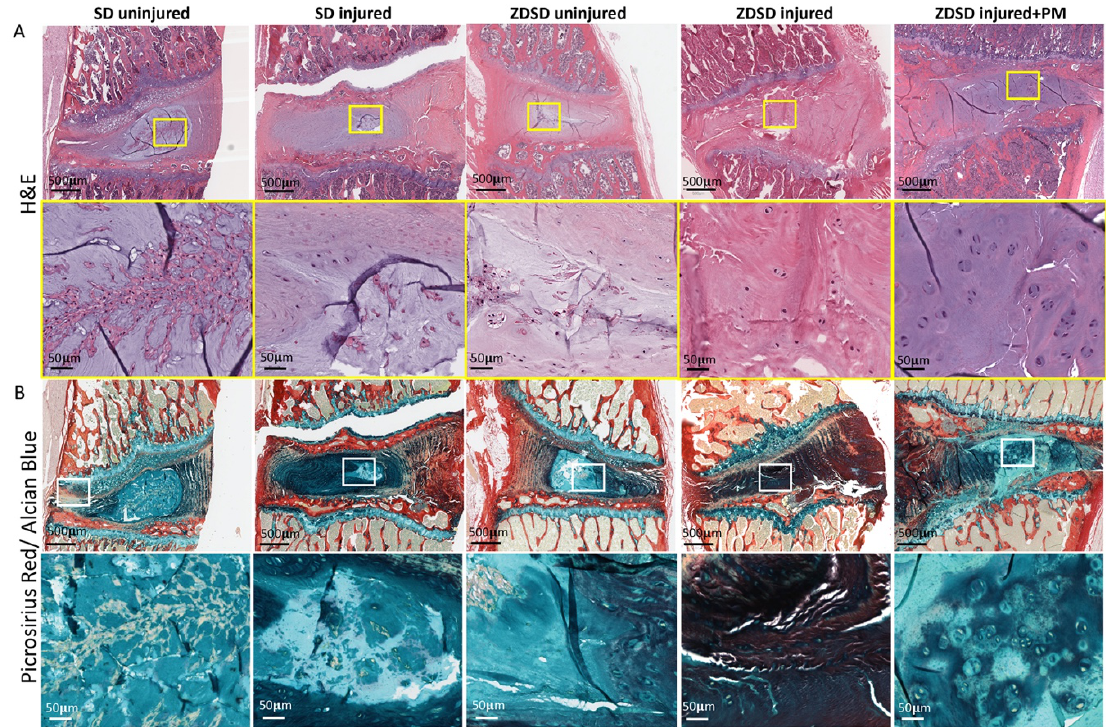
Figure 3. IVD lesion and NP destruction in response to needle injury is attenuated in rats receiving PM. ( A ) H&E-stained and ( B ) Picrosirius red/Alcian blue—stained lumbar discs from IVDs from various experimental groups harvested at 8 weeks post-surgery. Upper images in panels A and B show IVDs and adjacent endplates (scale bar: 500 μm). Lower images in panels A and B show magnification of the NP area (scale bar: 50 μm). Yellow and white rectangles indicate the area used for magnification, n ≥ 3 .